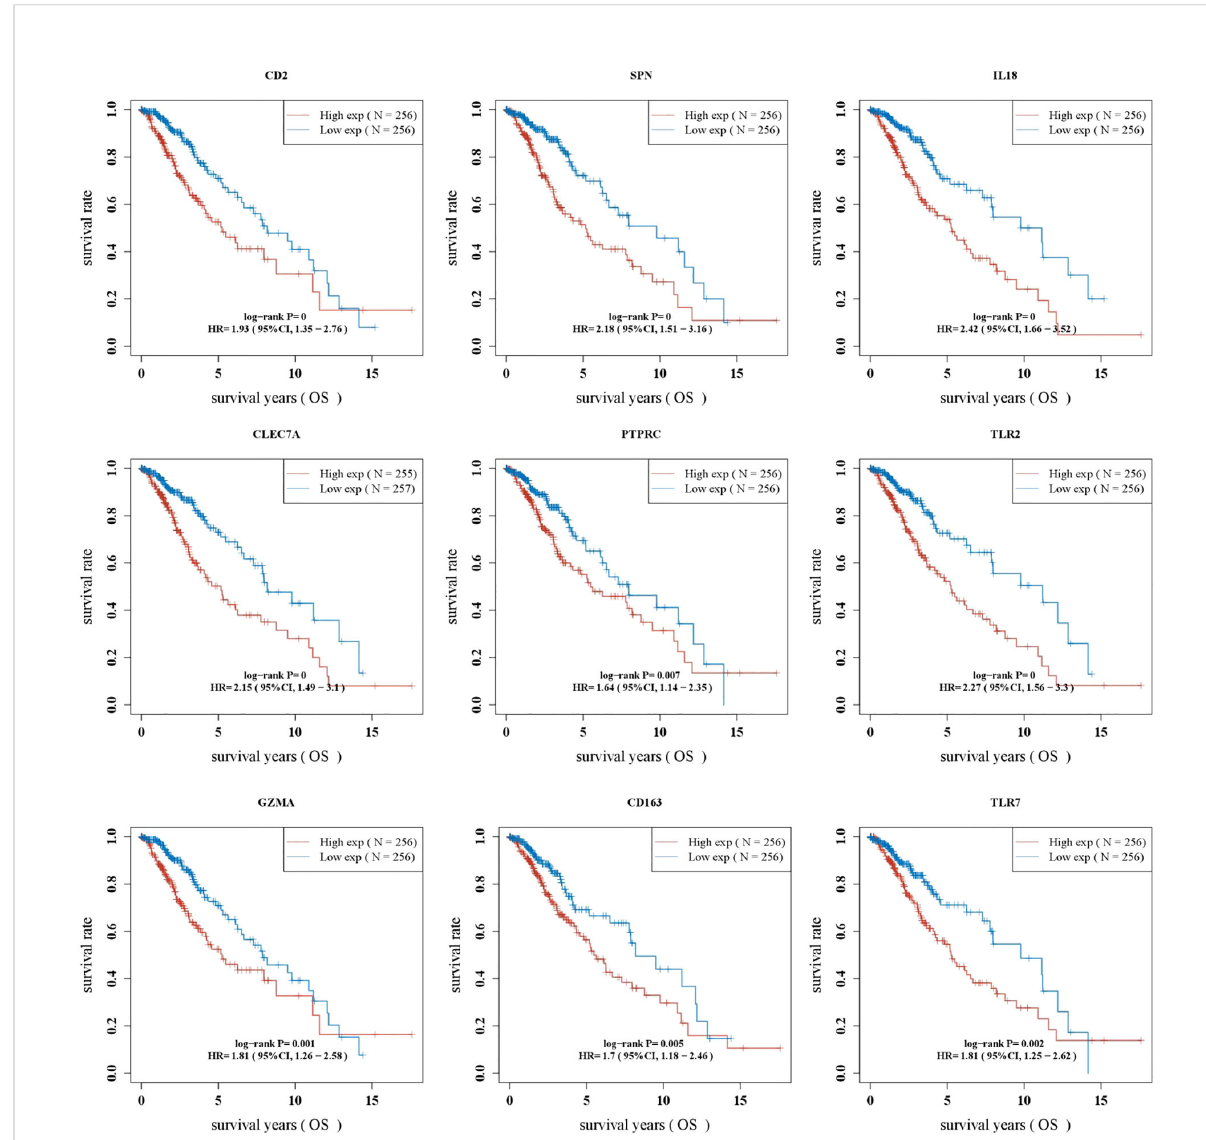
FIGURE 4 Batch survival analysis identifying LGG prognosis-related